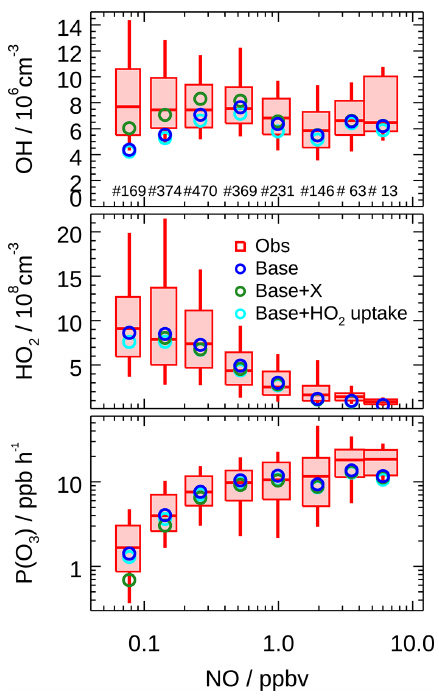
Figure 9. Dependence of measured and modeled OH, HO 2 , and P (O x ) on NO concentrations for daytime conditions ( j (O 1 D) > 0 . 5 × 10 − 5 s − 1 ). Box–whisker plot shows the median, the 75th and 25th percentiles, and the 90th and 10th percentiles of the measured results for each NO interval bin. Only median values are shown for modeled results. Numbers in the upper panel repre- sent the data points incorporated in each NO interval. Results from the base case, with an additional recycling process by a species X (equivalent to 100ppt NO) and with an additional HO 2 heteroge- neous uptake process (assuming γ to be 0.08), are all